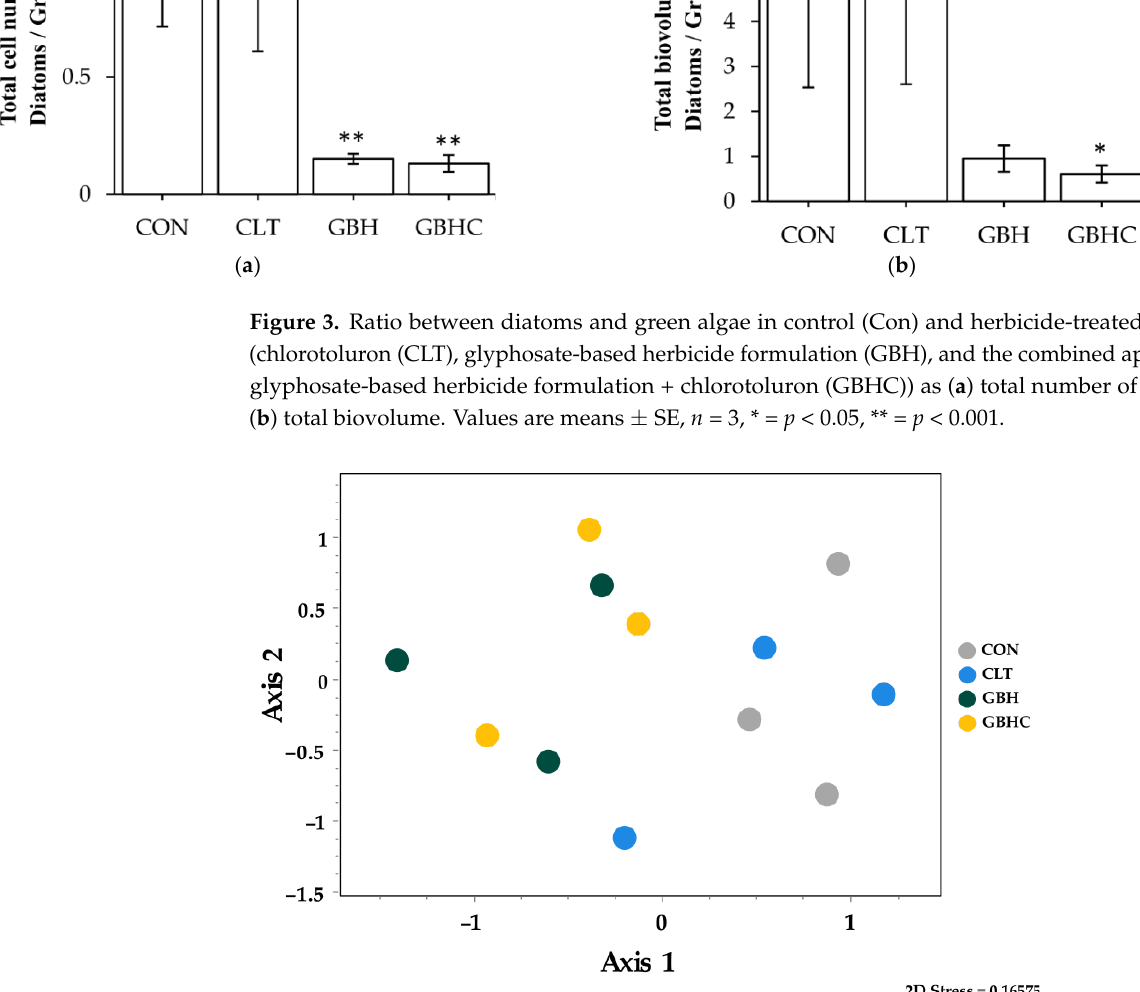
Figure 4. Axis 1 and 2 of NMDS, based on biovolumes of the entire species assemblage of the phytobenthos grown from inocula in the Mill Stream, a tributary of the River Frome, Dorset, UK. Treatments include control (CON), chlorotoluron (CLT), a glyphosate-based herbicide formulation (GBH), and the combined application of a glyphosate-based herbicide formulation + chlorotoluron (GBHC); each bubble represents the composition in a different flume; n = 3.